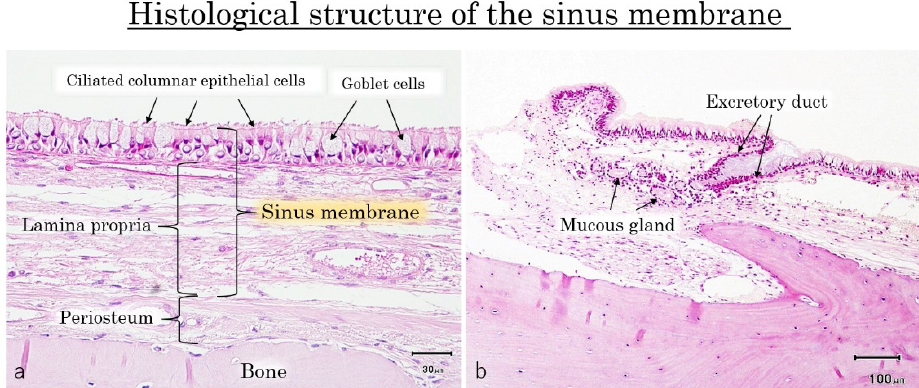
Figure 6. The sinus membrane was consisted of two layers. One was the surface layer with ciliated columnar epithelium cells and goblet cells, and the another was the lamina propria with loose connective tissue. Beneath the sinus membrane, the periosteum containing blood vessels was existed at the surface of bone ( a ). In this specimen, the mucous glands were observed in the lamina propria, and the excretory duct containing mucous was extended to the surface of sinus membrane ( b ).